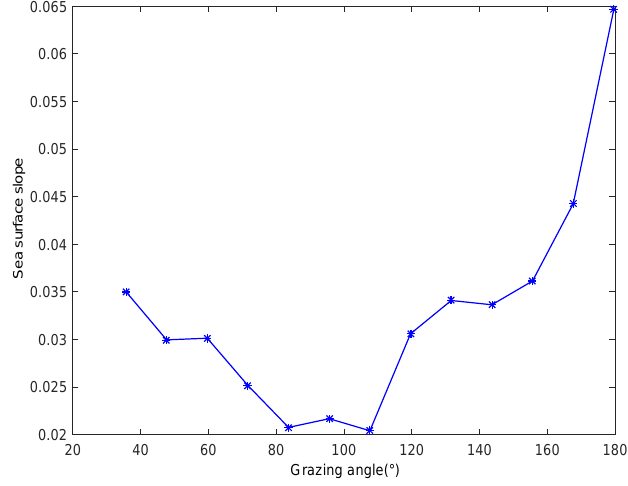
Figure 12. The estimated sea surface slope in